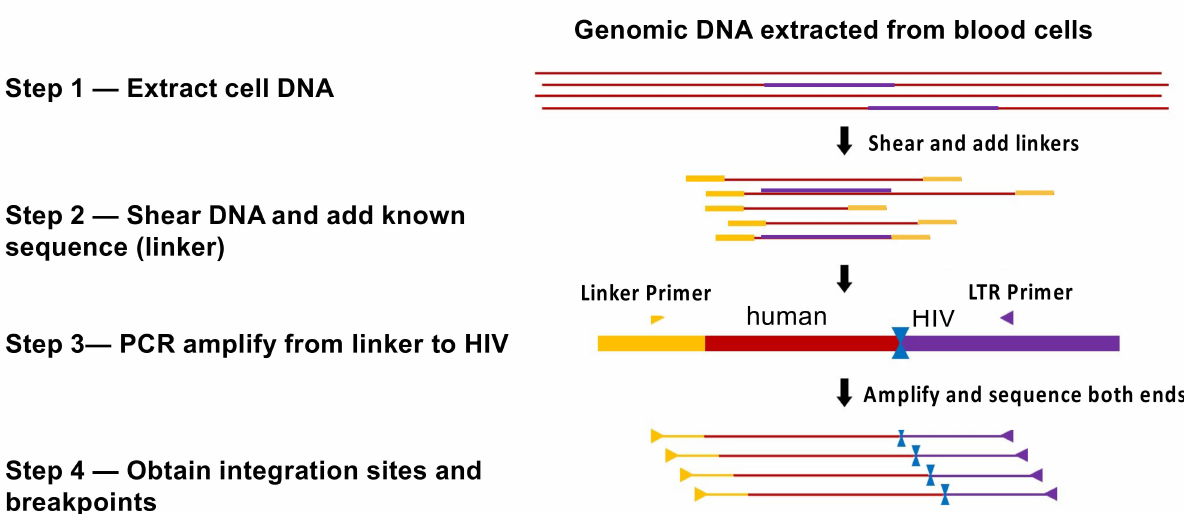
Figure 3. Integration site analysis. The method is based on an approach devised by Berry et al. [33]. DNA from infected cells is extracted and sheared to yield randomly distributed breakpoints in the host DNA, to which defined linkers are added. PCR amplification is initiated using primers complementary to the viral LTR and to the linker, ensuring that DNAs that have viral sequences are preferentially amplified. Amplification of DNAs with LTR and linker primers yields a collection of molecules with the integration site near one end and the breakpoint in the host DNA near the other. Both the sequence of the integration site and the breakpoint are determined by next-generation paired end sequencing. Clonally amplified proviruses are revealed by the presence of multiple sequences that have an identical integration site and that also have different breakpoints in the appended host